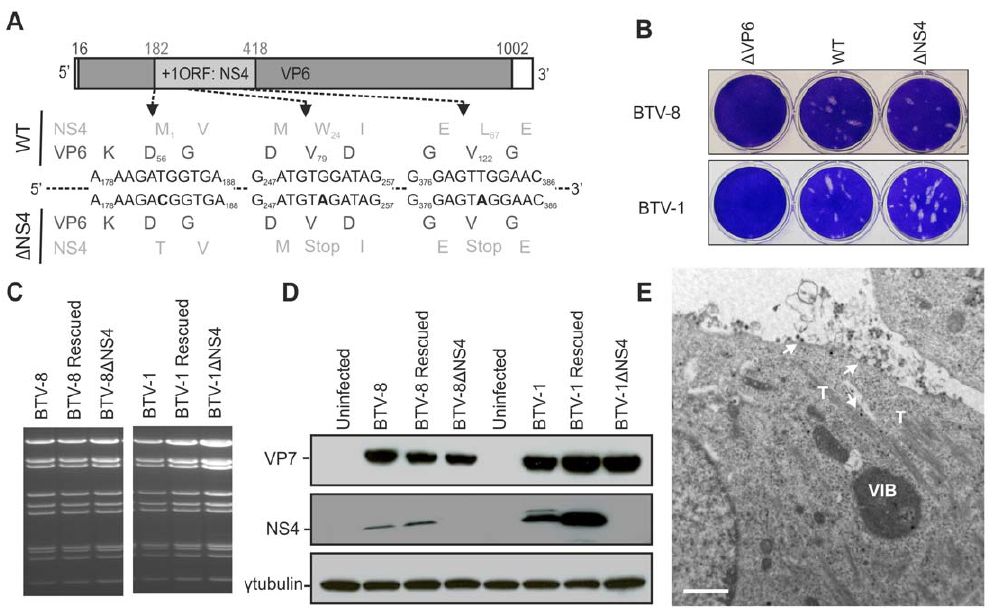
Figure 4. Generation of D NS4 Bluetongue viruses by reverse genetics. (A) BTV segment 9 open reading frames. VP6 amino acid residues are written in black, NS4 amino acid residues are written in grey. The nucleotides at positions 183 (T), 252 (G) and 381 (T) were mutated to C, A and A, respectively (bold). Note that whilst these mutations do not change any amino acid residues of VP6, they remove the initiation codon of NS4 (position182) and introduce two stop codons into the NS4 coding sequence at amino acid positions 24 and 67. (B) Transfected BSR cells with BTV transcripts generated in vitro (0.5 6 10 11 molecules per segment for BTV-1 and 1 6 10 11 molecules per segment for BTV-8). Cell monolayers were stained using crystal violet at 72 h post-transfection. As negative controls, D VP6 assays correspond to using a segment 9 containing a stop codon at position 79 in the VP6 gene. (C) Agarose gel (1.5%) of purified BTV genomic dsRNA. BSR cells infected at a MOI of 0.01 were collected at 72 h post infection and BTV dsRNA was purified as described in the Materials and Methods. 2 m g of dsRNA was loaded in each lane. (D) Western blotting of cellular extracts (lysate) of BSR cells infected at a MOI of 0.01. Cells were analyzed 36 h post-infection and blots were incubated with antisera against VP7, NS4 and c -tubulin as indicated. Note that the double NS4 band in the BTV-1 sample is not a feature observed consistently. (E) Electron microscopy of BSR cells infected by BTV1- D NS4. Note cells display all the major features of BTV-infected cells including NS1 tubules (T), viral inclusion bodies (VIB) and viral particles (arrows). Scale bar=1 m